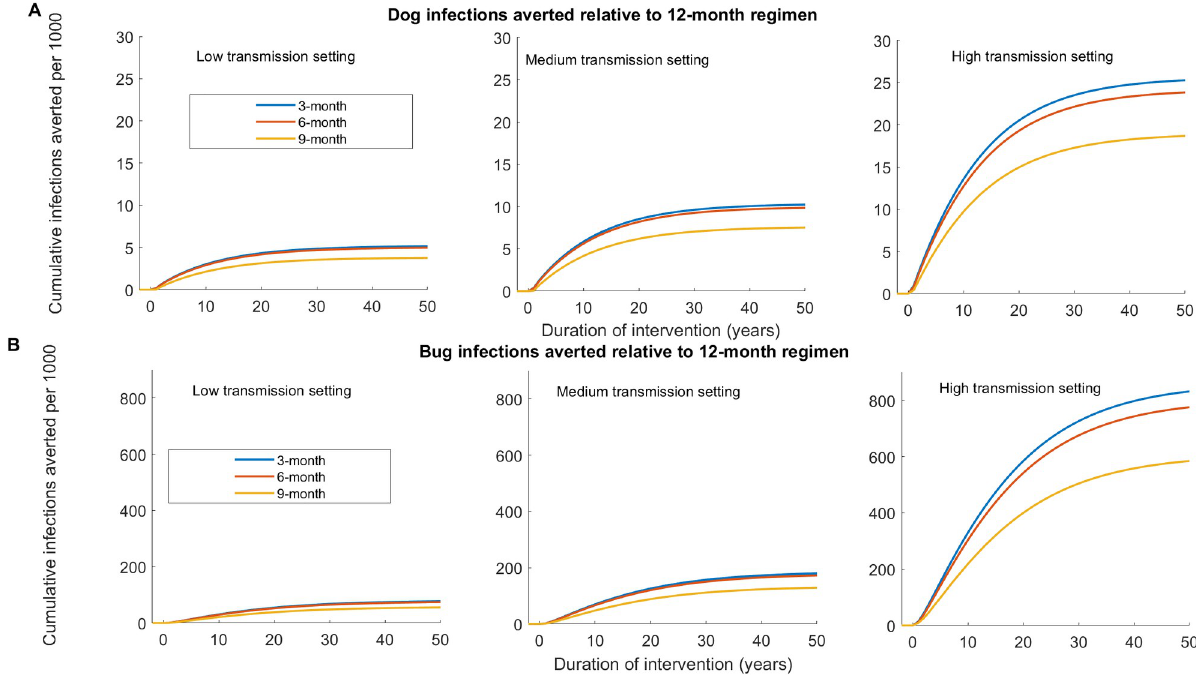
Fig 4. Relative effectiveness of dog treatment regimen for reducing T . cruzi infections among dogs and triatomines compared to a 12-month treatment regimen using Model 1. Effectiveness is computed using the single host-vector model without seasonality. (A) Cumulative additional dog infections averted under the 3-month, 6-month, and 9-month regimen relative to the 12-month regimen in the low, medium, and high transmission settings. (B) Cumulative additional triatomine infections averted under the 3-month, 6-month, and 9-month regimen relative to the 12-month regimen in the low, medium, and high transmission